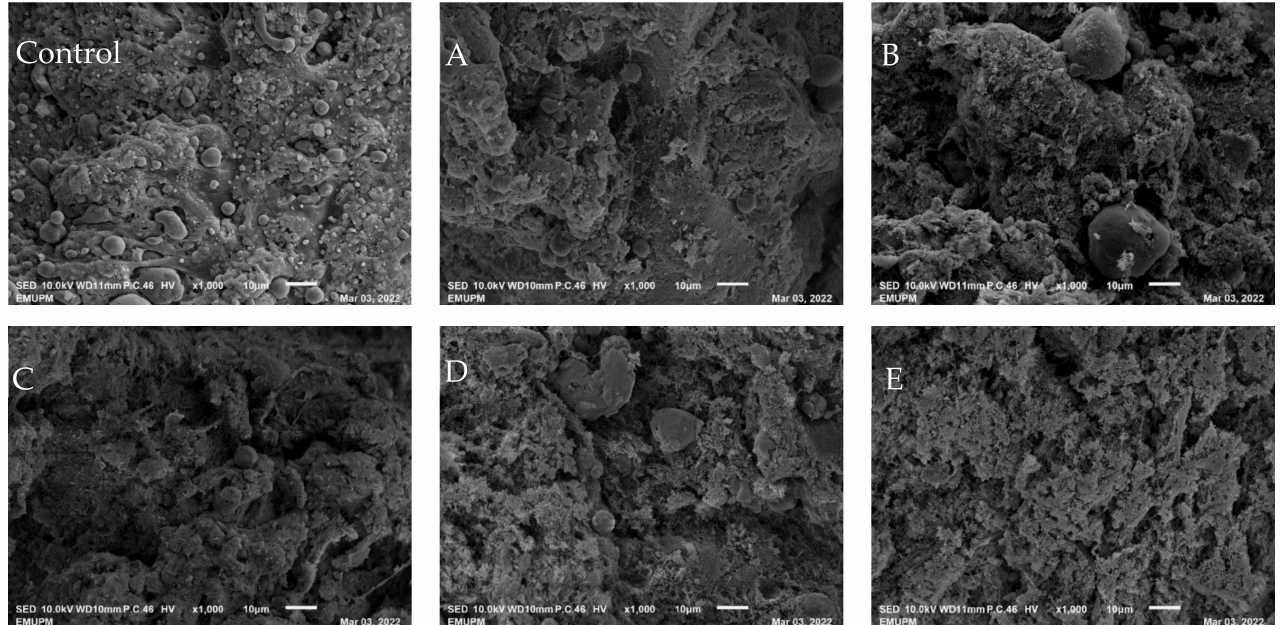
Figure 5. SEM photomicrograph of fat-replaced samples with palm shortenings (PS) of various melting ranges (MR) as compared to the control sample with chicken skin. (control—e: 1000 × magnification). Control (chicken skin), sample A (PS at MR of 33–36 ◦ C), sample B (PS at MR of 38–42 ◦ C), sample C (PS at MR of 44–46 ◦ C), sample D (PS at MR of 45–49 ◦ C), and sample E (PS at MR of 55–60 ◦